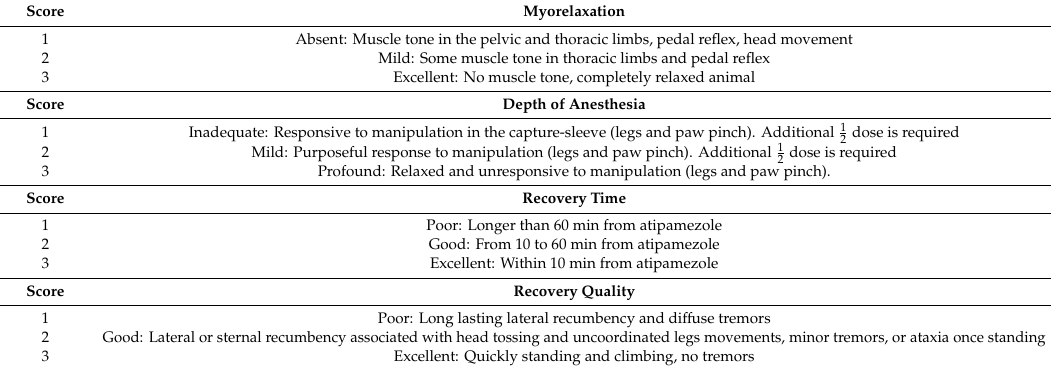
Figure 1. A gray squirrel moved from the live trap to the “capture-sleeve” to allow safe handling ( A ) and exteriorization of a hind limb for intramuscular injection through the zipper ( B ). Table 1. Descriptive Scoring System (DSS) developed for this study and used to categorize the quality and depth of anesthesia and the quality of recovery in wild gray squirrels undergoing